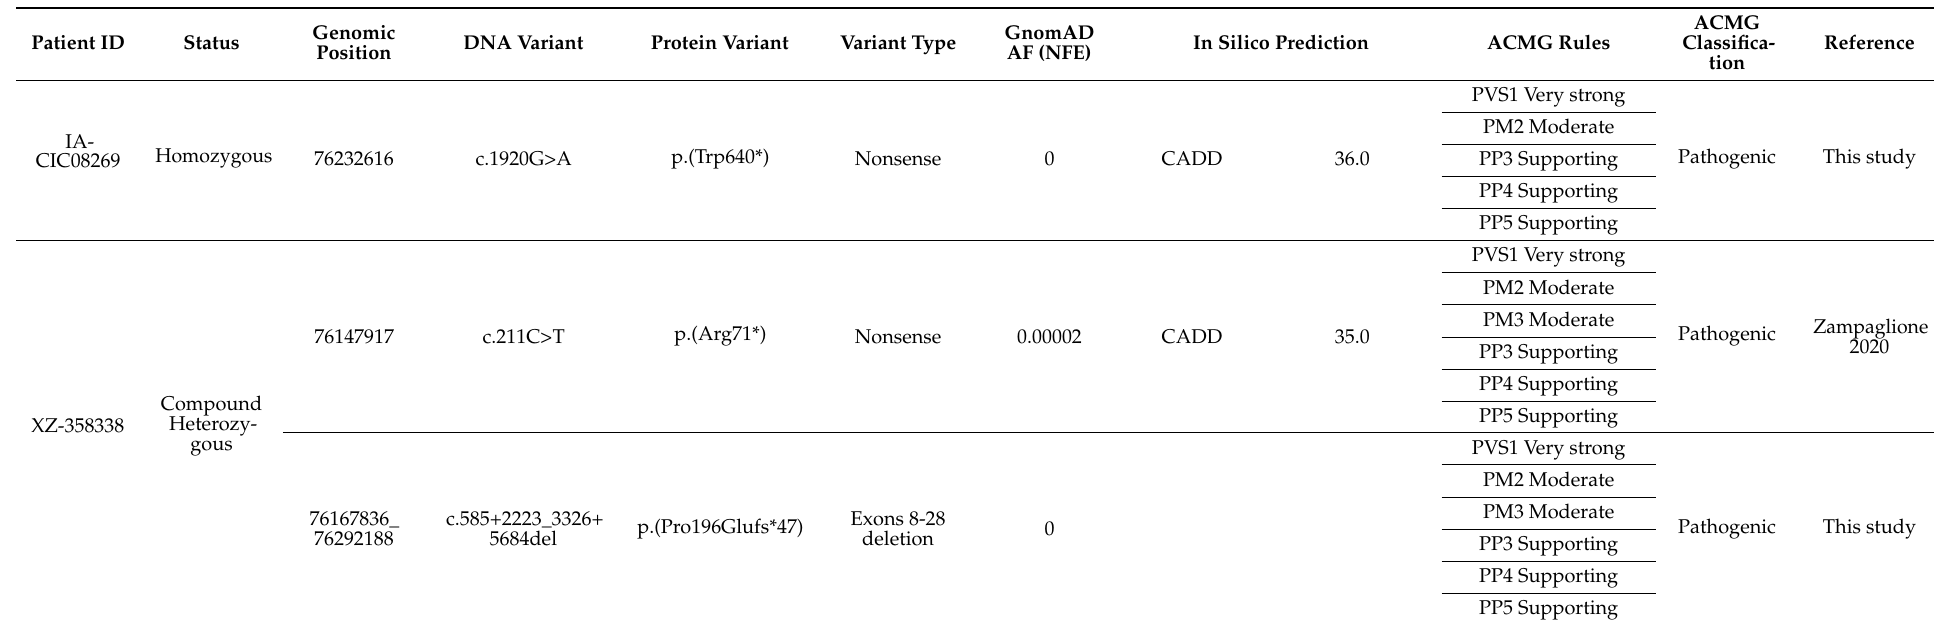
Table 2. In silico variant